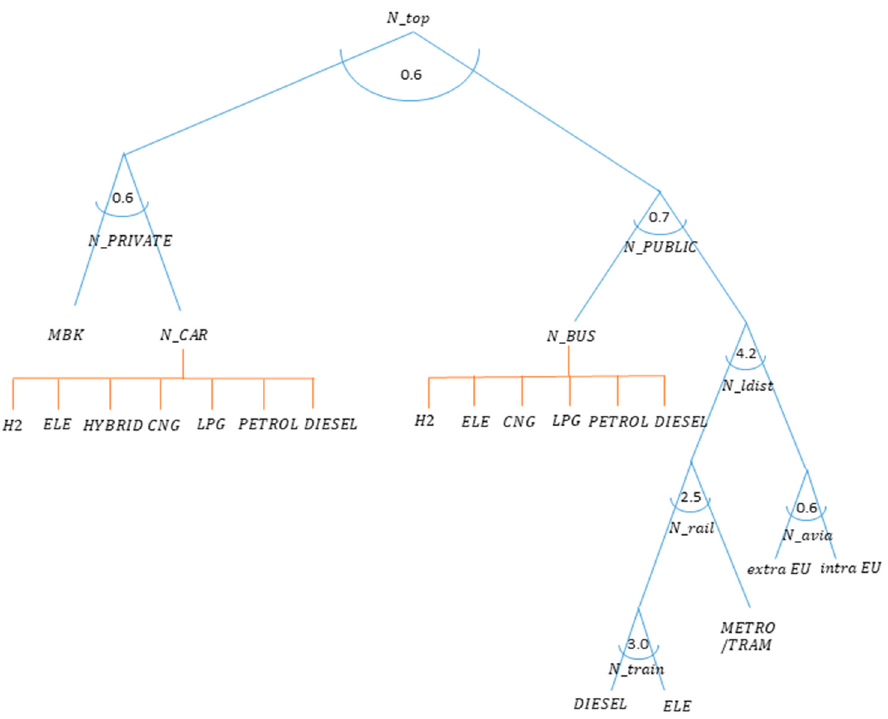
Figure 2. Passenger transport decision tree. Source: Own elaboration see also [28].